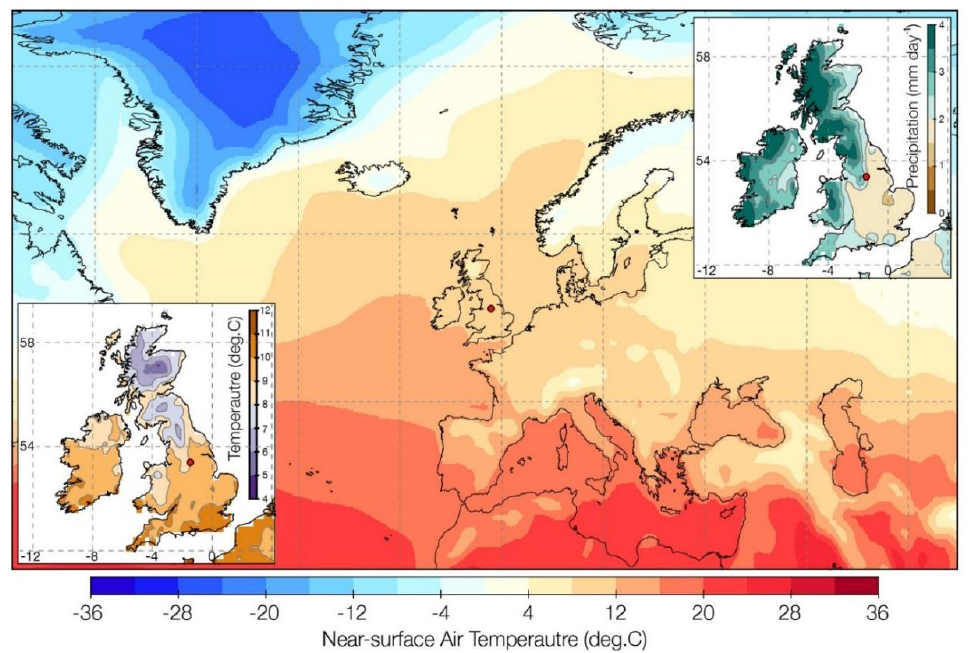
Figure 1. The mean annual temperature (1979–2015) at 2 m height (above land) and sea-surface temperature (above oceans) from the ERA-Interim Reanalysis [12]. Inset plots show the mean annual temperature and precipitation (1950–2015) from the E-OBS dataset [13] focused on the UK. The location of WP is indicated by a red marker in all panels. Plot units are degrees Celsius and mm day −1 .